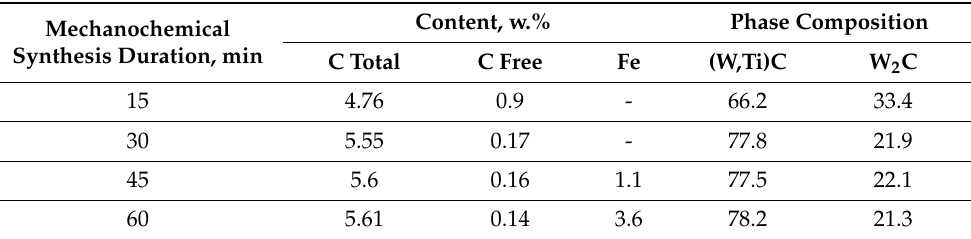
Table 5. Chemical and phase composition of the mechanochemically synthesized WC. Mechanochemical Synthesis Duration,